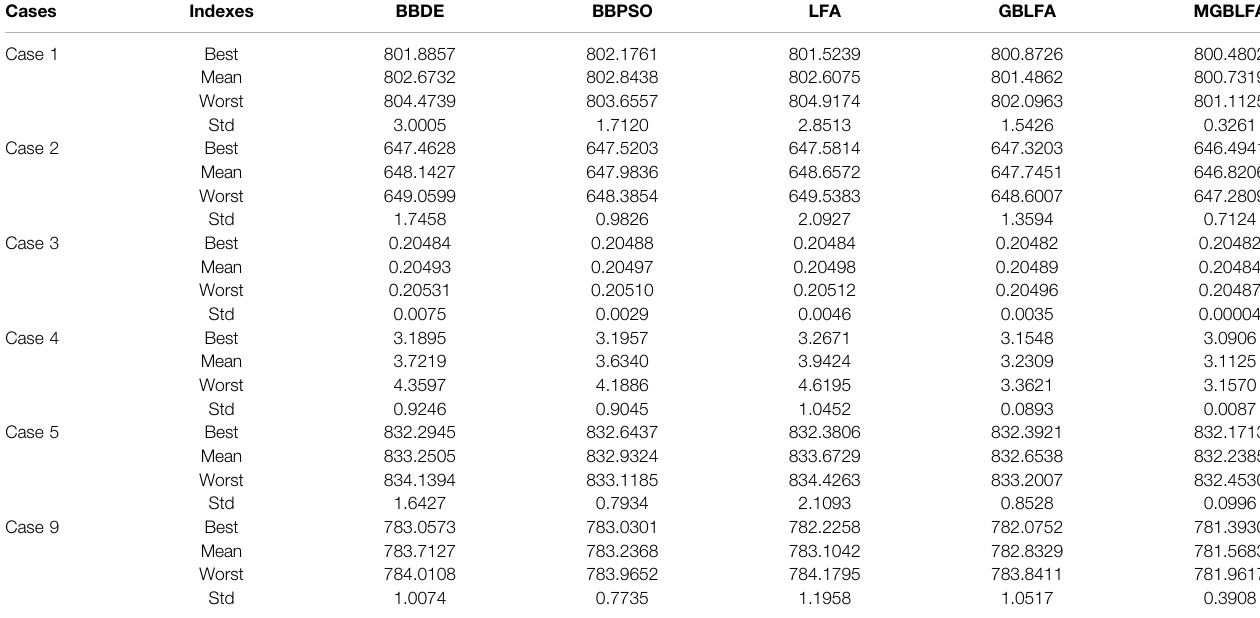
TABLE 13 | Comparison of optimal results by the optimization algorithms for single-objective functions.